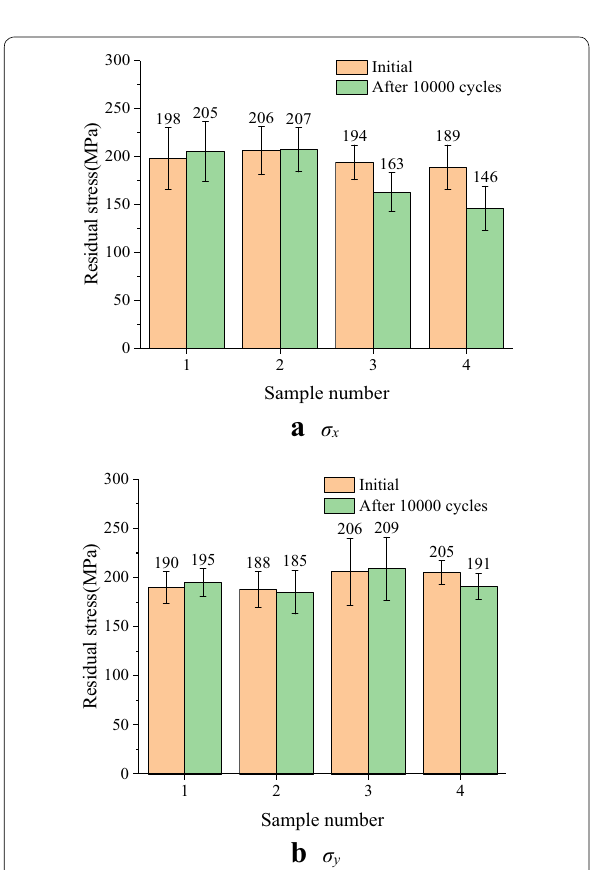
Figure 7 Surface residual stress of samples 1 ‒ 4 before and after cyclic